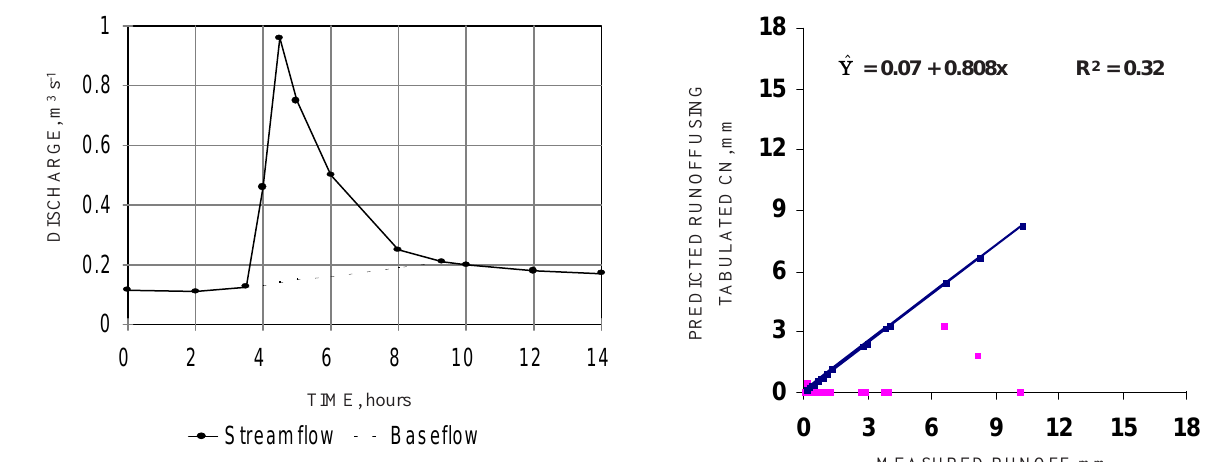
Figure 2. Capetinga watershed flood hydrograph showing baseflow curve and runoff separation starting at about 4:00 pm, on May 22, 1997.